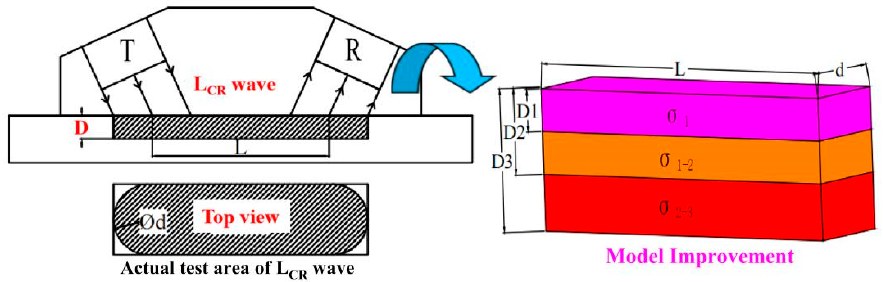
Figure 10. Simplified model of L CR wave detection zone.